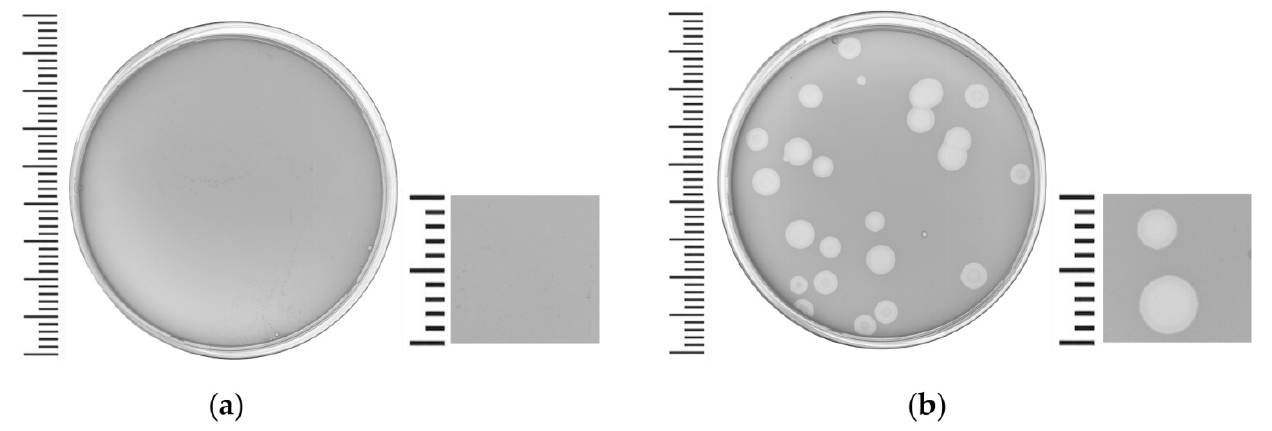
Figure 1. Pseudomonas phage Pf-10 plaque morphology on 0.75% (w/v) LB agar overlay. ( a ) Control plate: non-infected sensitive strain P. syringae BIM B-268. ( b ) Plaques formed by the Pf-10 phage on the lawn of strain P. syringae BIM B-268.